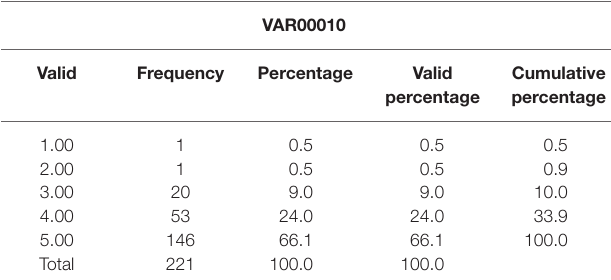
TABLE 10 | Activity has motived me because I consider it to be useful for my future career.